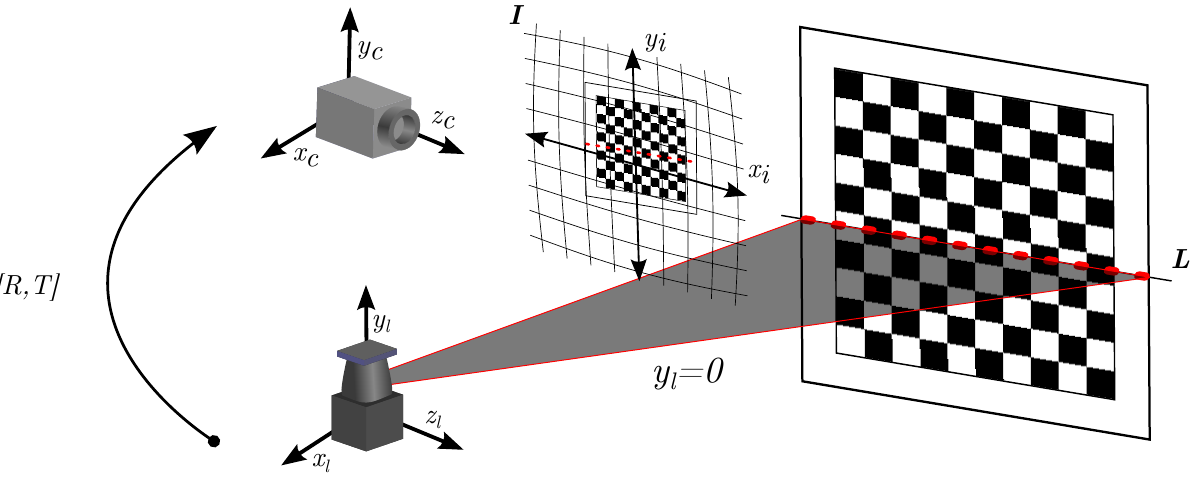
, y , x ). The extrinsic l l l = 0 l